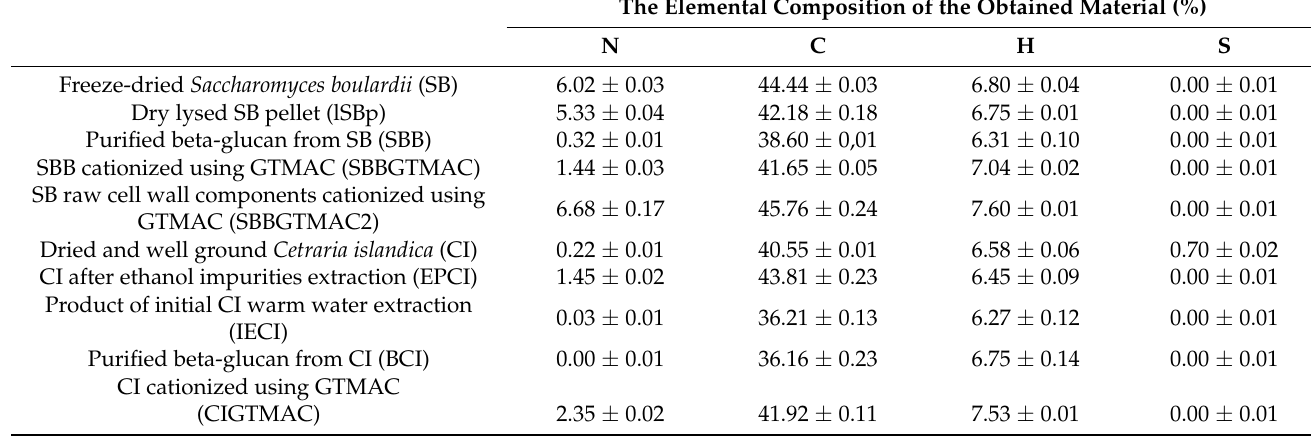
Table 1. Elemental composition in the obtained materials at subsequent stages of isolation and modification of polysaccha- rides. The results are presented as mean of three independent measurements ± standard deviation (SD). The Elemental Composition of the Obtained Material (%) N C H